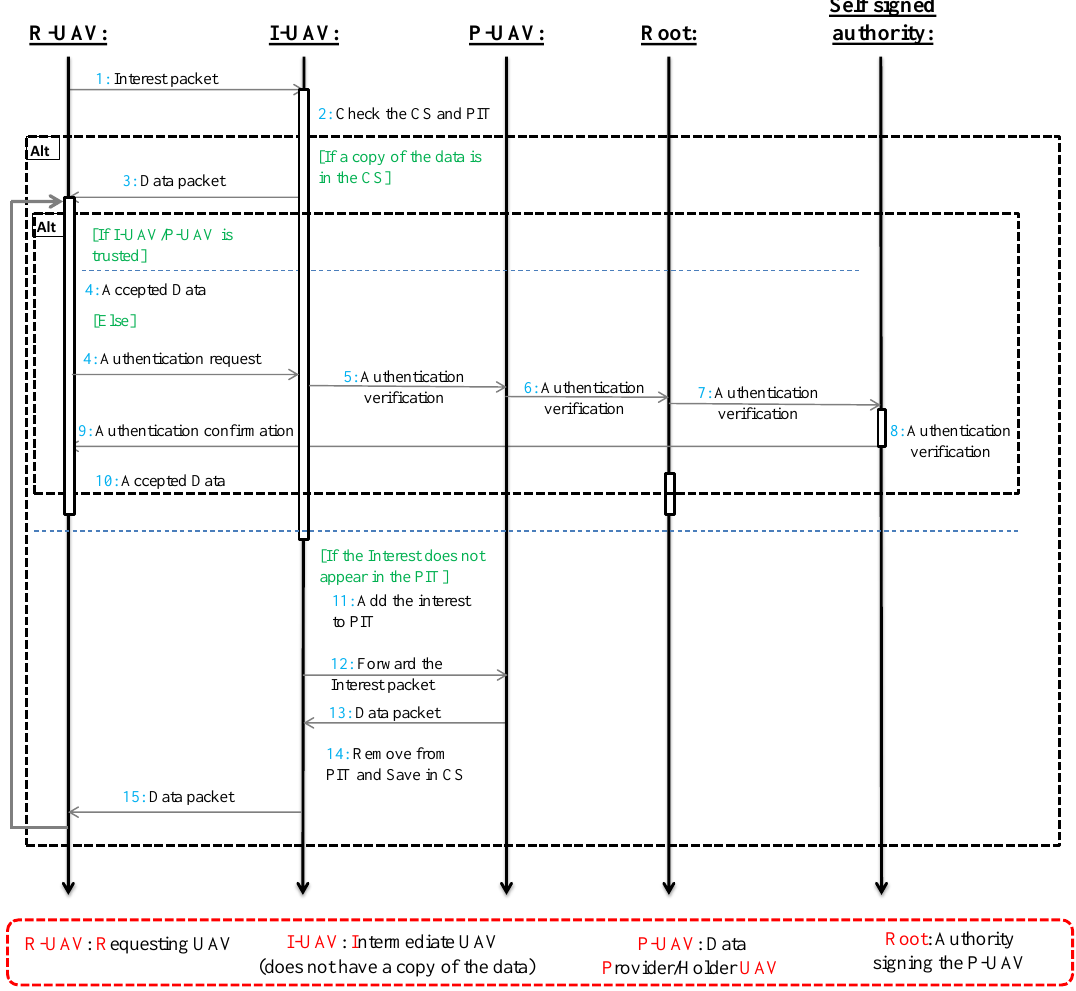
Figure 8. Sequence diagram of the proposed lightweight data authentication